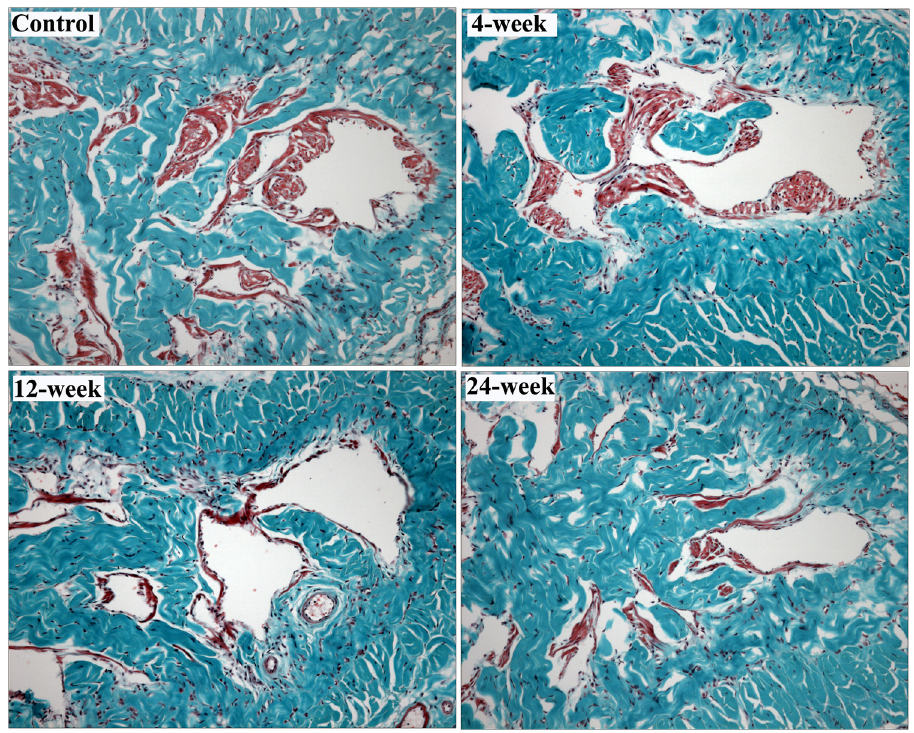
Fig 4. Smooth muscle content in the corpus cavernosum. Representative images from rats in the control, 4-week, 12-week and 24-week groups were shown. Smooth muscle and connective tissue are stained with red and blue, respectively, using the trichrome method. The smooth muscle content was higher in control group than in 12-week and 24-week groups. Magnification is x100.